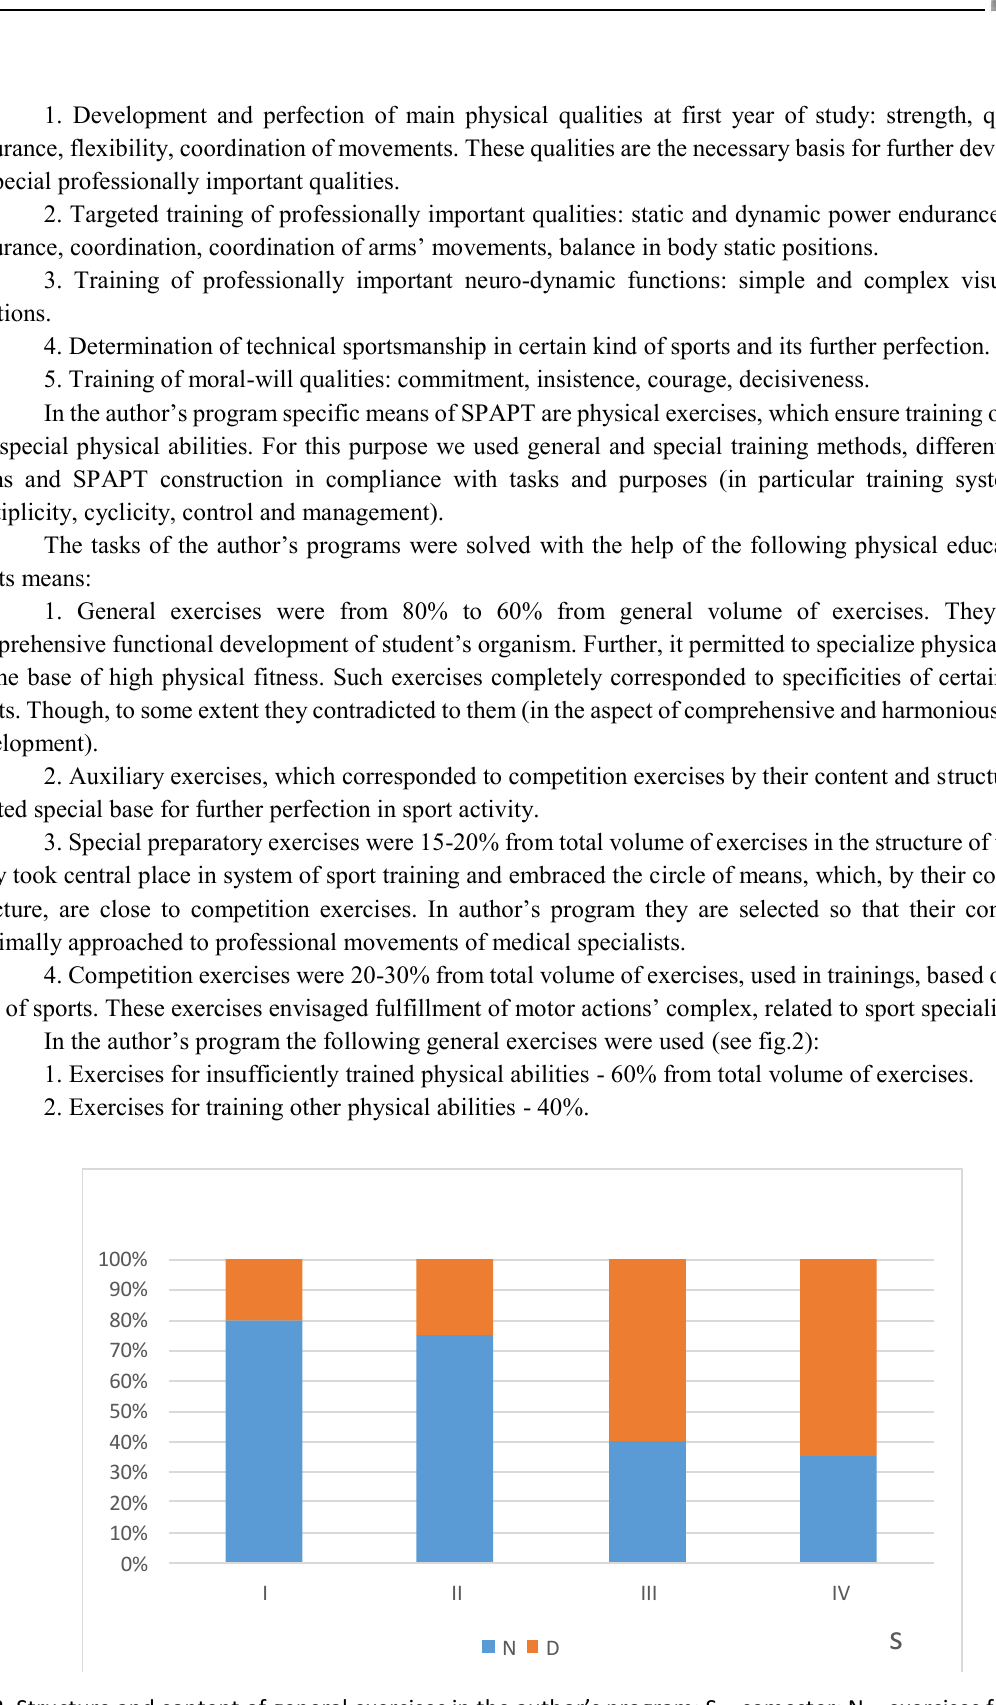
Fig.2. Structure and content of general exercises in the author’s program: S – semester; N – exercises for insufficiently trained physical abilities; D – exercises for other physical